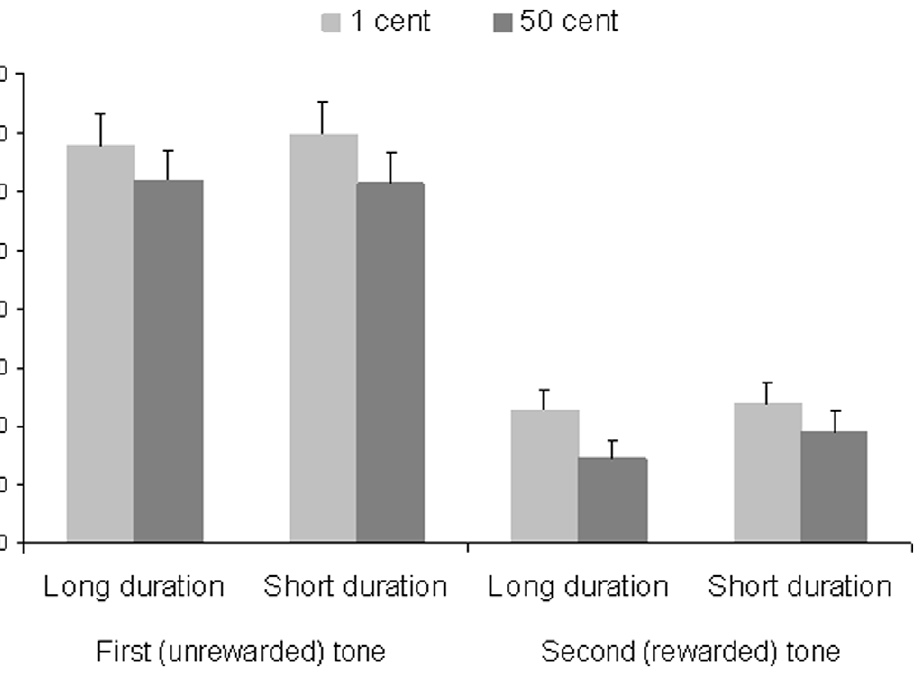
Figure 2. Mean reaction times of responses to the first (unrewarded) and second (rewarded) tone in a series as a function of reward value and reward presentation duration. Error bars represent standard errors.